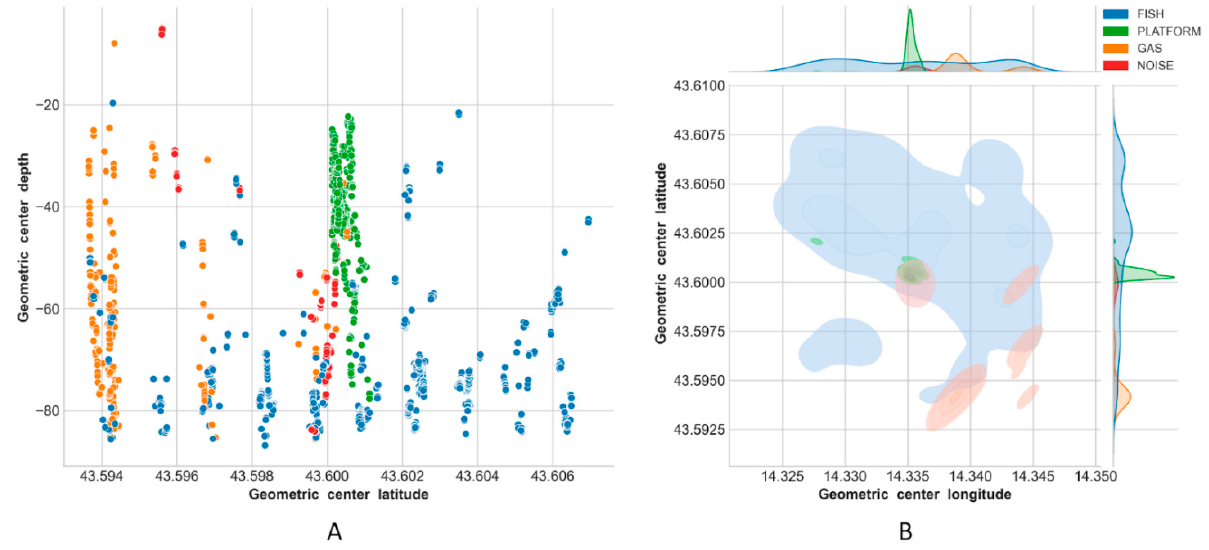
Figure 13. Predictions on Survey 1: latitude-depth view ( A ), and Kernel Density Estimation plot (top view) ( B ).